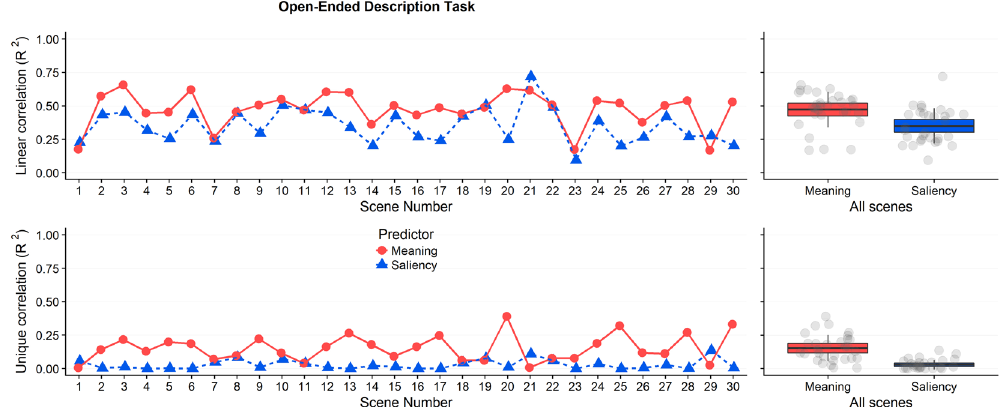
Figure 4. Squared linear correlation and semi-partial correlation by scene and across all scenes in Experiment 2. The line plots show the linear correlation (top) and semi-partial correlation (bottom) between fixation density and meaning (red) and salience (blue) by scene. The scatter box plots on the right show the corresponding grand mean (black horizontal line), 95% confidence intervals (colored box), and 1 standard deviation (black vertical line) for meaning and salience across all 30